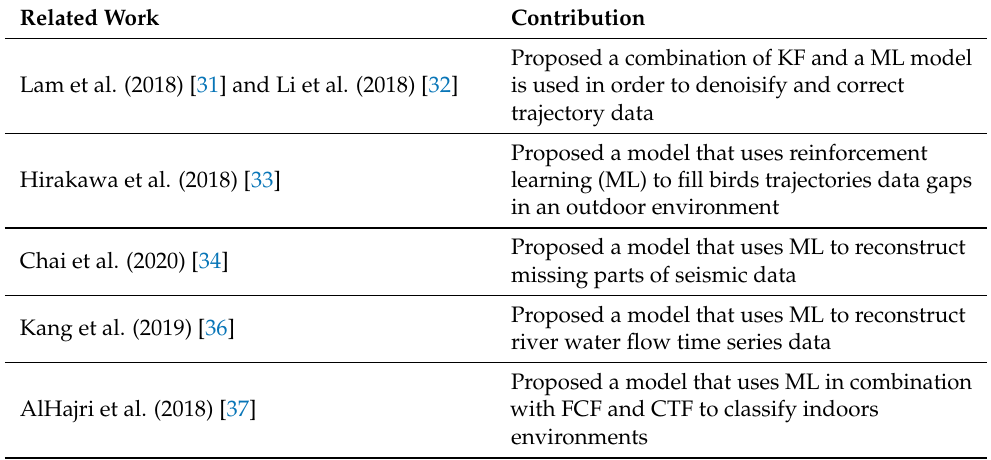
Table 1. Contributions of related